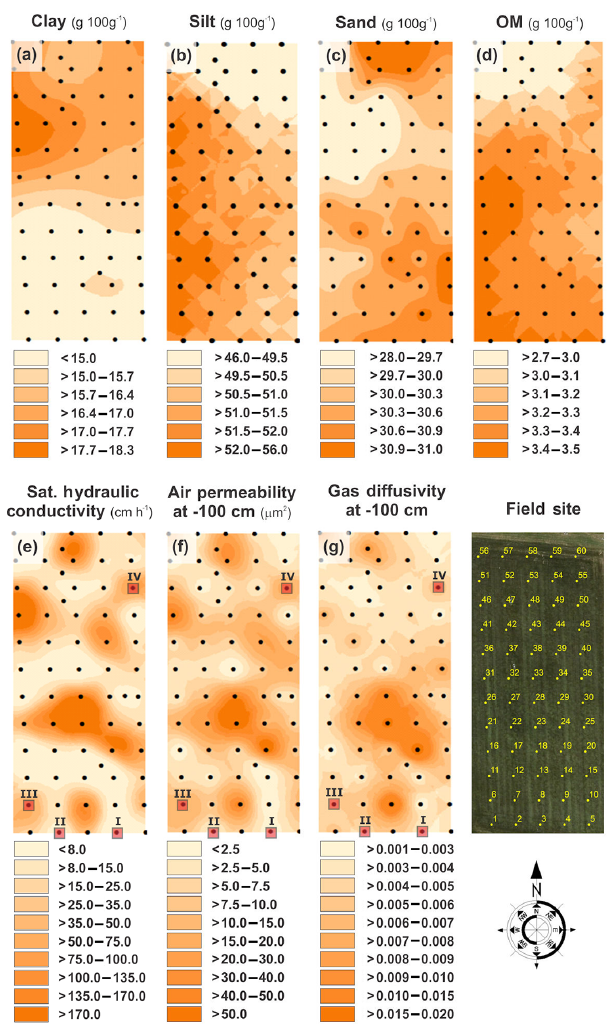
Figure 2. Contour maps depicting the spatial distribution of soil tex- tural properties and macropore flow parameters; (a) clay (<2µm), (b) silt (2–50µm), (c) sand (50–2000µm), (d) organic matter con- tent, (e) saturated hydraulic conductivity (cmh − 1 ) , (f) air perme- ability (µm 2 ) at − 100cm matric potential, and (g) gas diffusivity at − 100cm matric potential. Visualizations of samples marked as I, II, III, and IV are depicted in Fig.